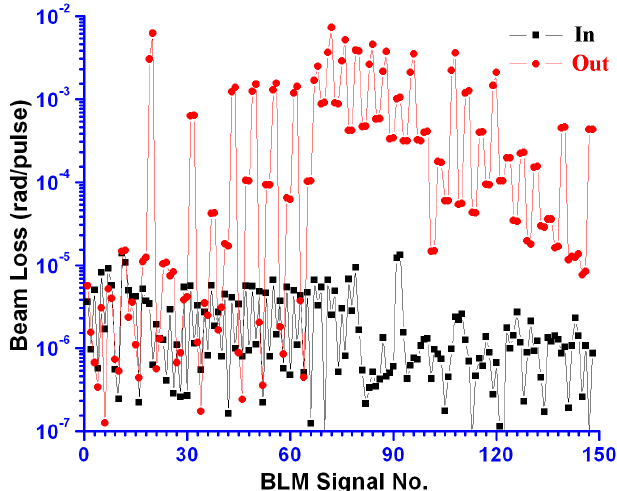
FIG. 7. (Color) Longitudinal acceptance measured at the second SCL cavity with the BCM at the exit of the